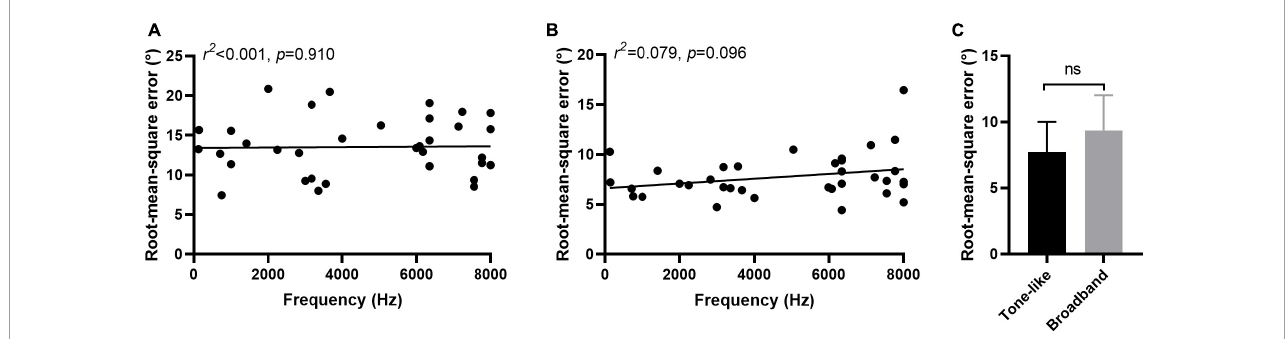
FIGURE6 Effect of characteristic of tinnitus on sound localization behavior. No correlation was found between tinnitus-matched pitch and RMSE scores in PT (A) and MS (B) condition. (C) No difference was found of the ability to localized monosyllable stimuli between participants with tone-like tinnitus and with broadband noise-like tinnitus. Ns, not